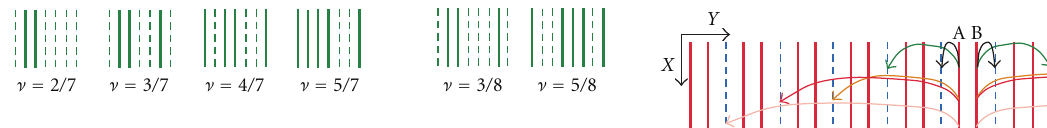
Figure 7: Filling ways with higher classical Coulomb energy.